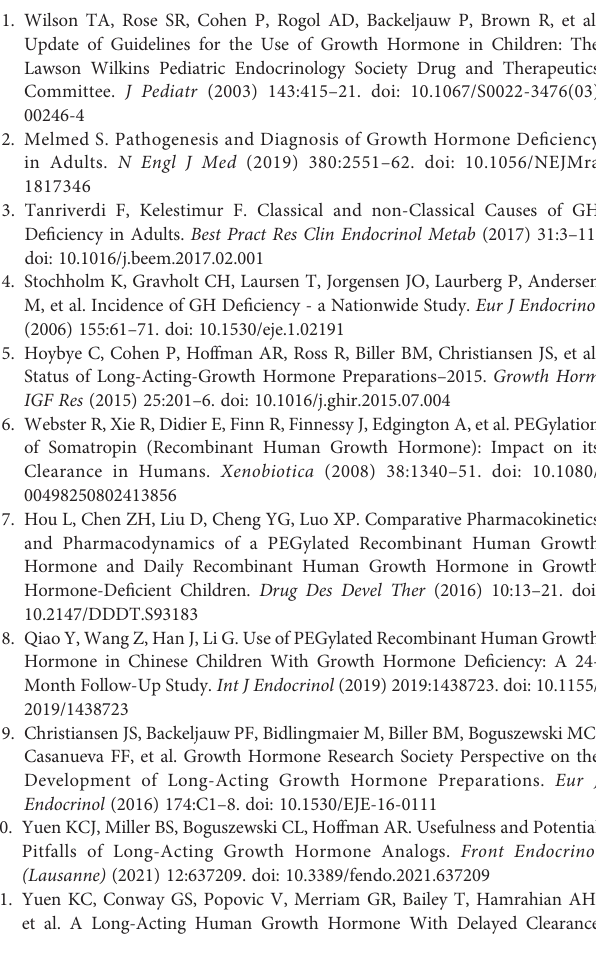
Supplementary Figure 2 | H&E staining of macrophages in cynomolgus monkeys with 52-week administration of Jintrolong. (A) . Lung of Jintrolong group with 3mg/kg/week administration for 52 weeks, arrows indicate the macrophages in lung. (B) . Liver of Jintrolong group with 3mg/kg/week administration for 52 weeks, arrows indicate the Kupffer cells in liver. (C) . Spleen of Jintrolong group with 3mg/kg/week administration for 52 weeks, arrows indicate the macrophages in spleen. (D) . Brain of Jintrolong group with 3mg/kg/week administration for 52 weeks, arrows indicate the microglias in brain.